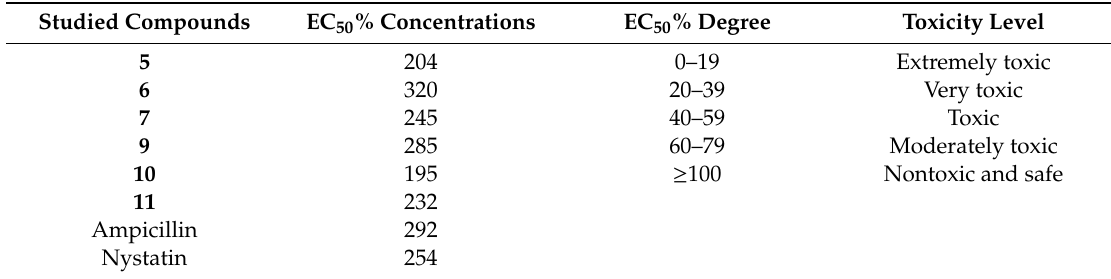
Table 3. The values of Microtox ® EC 50 percent concentrations of all studied designed compounds. Studied Compounds